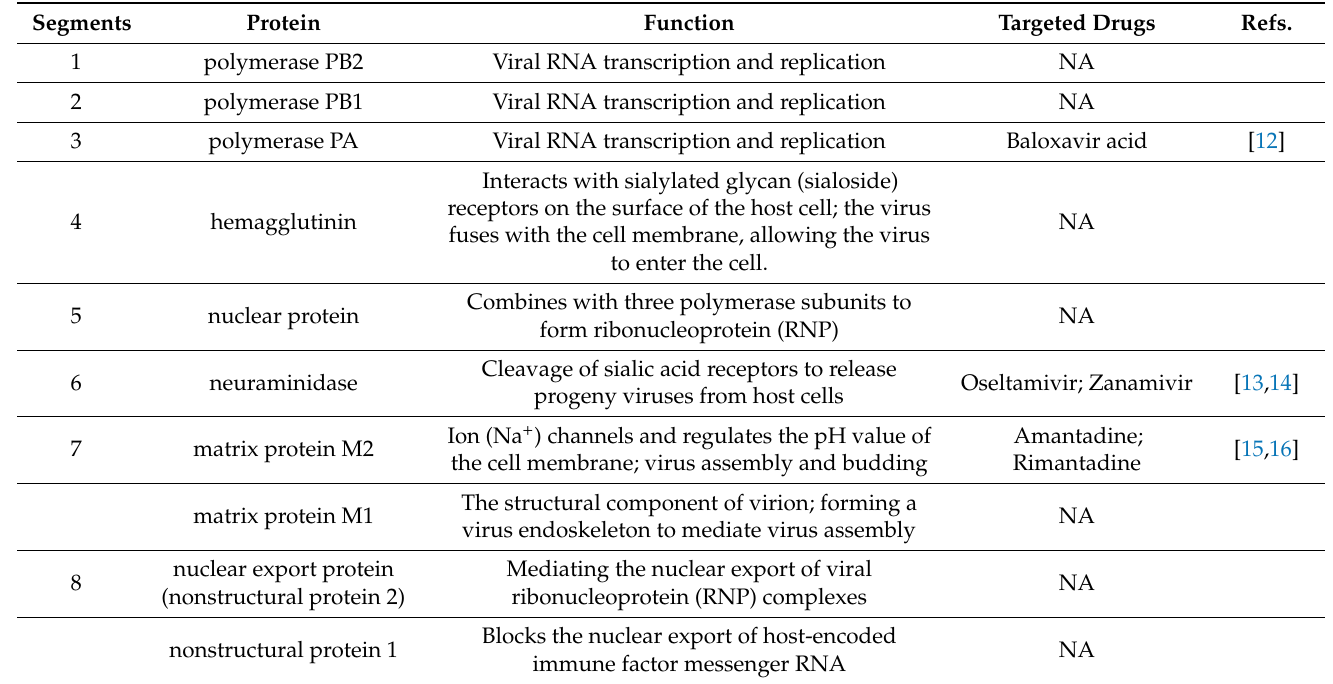
Table 1. Influenza A virus genome segments encode protein, function, and targeted